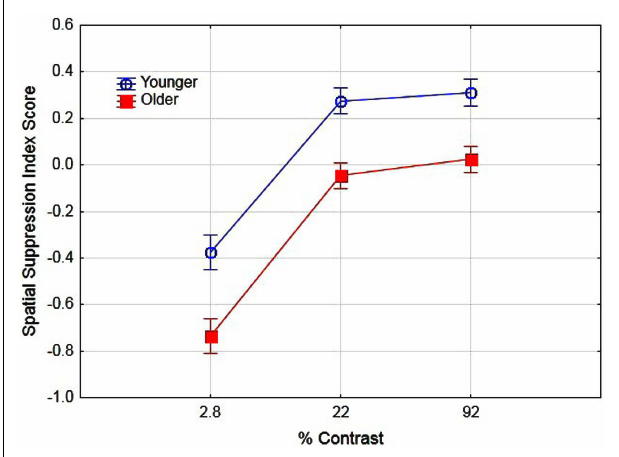
FIGURE 3 | Effects of contrast and age on spatial suppression index scores. Error bars represent ± 1 SE.